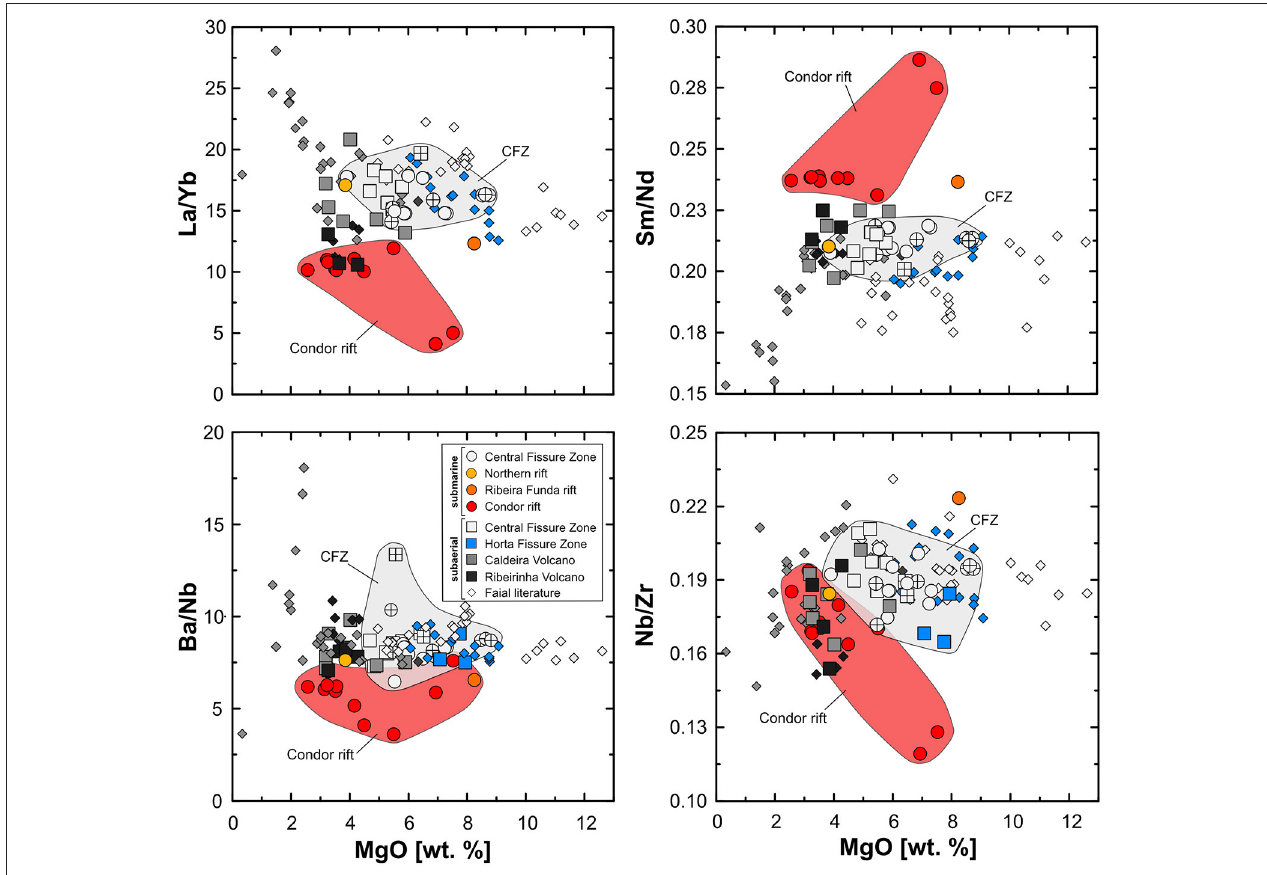
FIGURE 5 | Incompatible trace element variations of submarine and subaerial lavas from Faial. Data sources are the same as in Figure 4 . (CFZ = Central Fissure Zone).